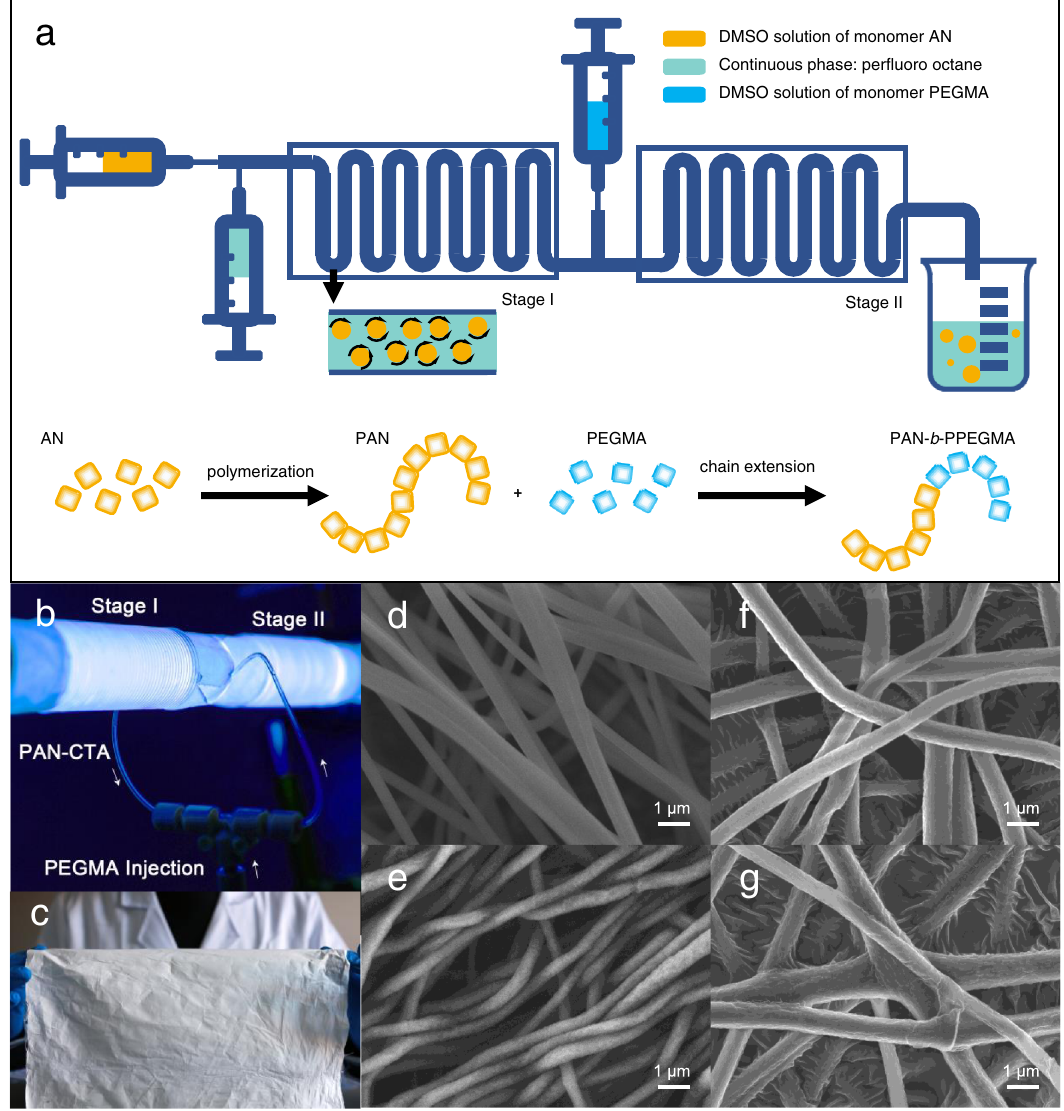
Fig. 7 Continuous synthesis and electrospinning processing of polymers. a Schematic illustration of the continuous droplet- fl ow reactor for PET-RAFT polymerization. b Digital photo of the continuous- fl ow photopolymerization setup. c Digital photo of the ENM of PAO m - b -PPEGMA n3 . d SEM image of the ENM of PAN. e SEM image of the ENM of PAO. f SEM image of the ENM of PAN m - b -PPEGMA n3 . g SEM image of the ENM of PAO m - b -PPEGMA n3 . Table 1 Molecular structures of the PAN m - b -PPEGMA n intermediates and PAO m - b -PPEGMA n products with different block ratios.